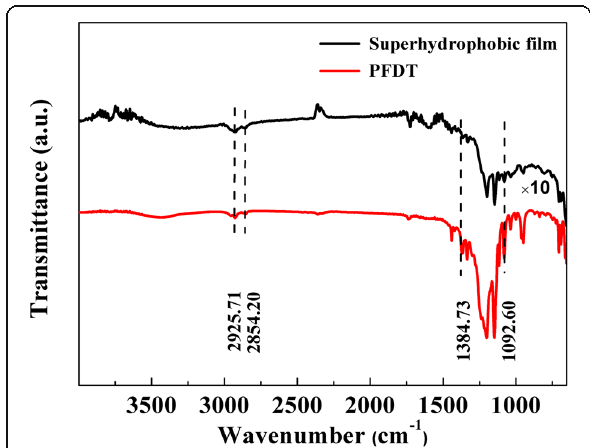
Fig. 4 FT-IR spectra of PFDT and the superhydrophobic film (PFDT modified AgNWs@AgNPs films)